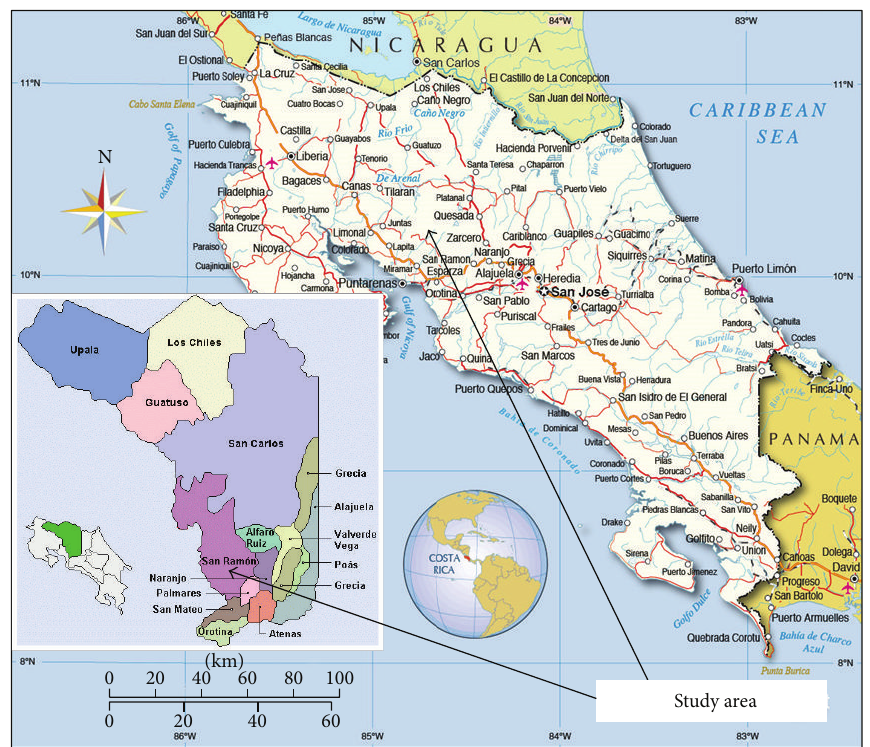
Figure1:Mapwithlocationofthestudyarea“ReservaBiol´ogicaAlbertoManuelBrenesdeSanRam´on,”CostaRica(coordinates:10 ∘ 16 󸀠 00.94 󸀠󸀠 N and 84 ∘ 36 󸀠 36.02 󸀠󸀠